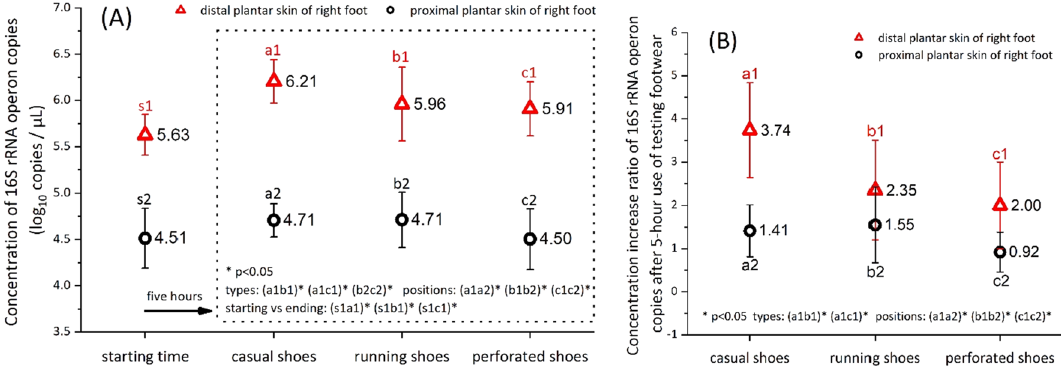
Figure 6. Concentrations (A) and concentration increase ratios (B) of 16S rRNA operon copies at the distal plantar skin (metatarsal and toe-web regions) and the proximal plantar skin (heel regions) of the right foot after 5-h use of three footwear types (mean ± SD).